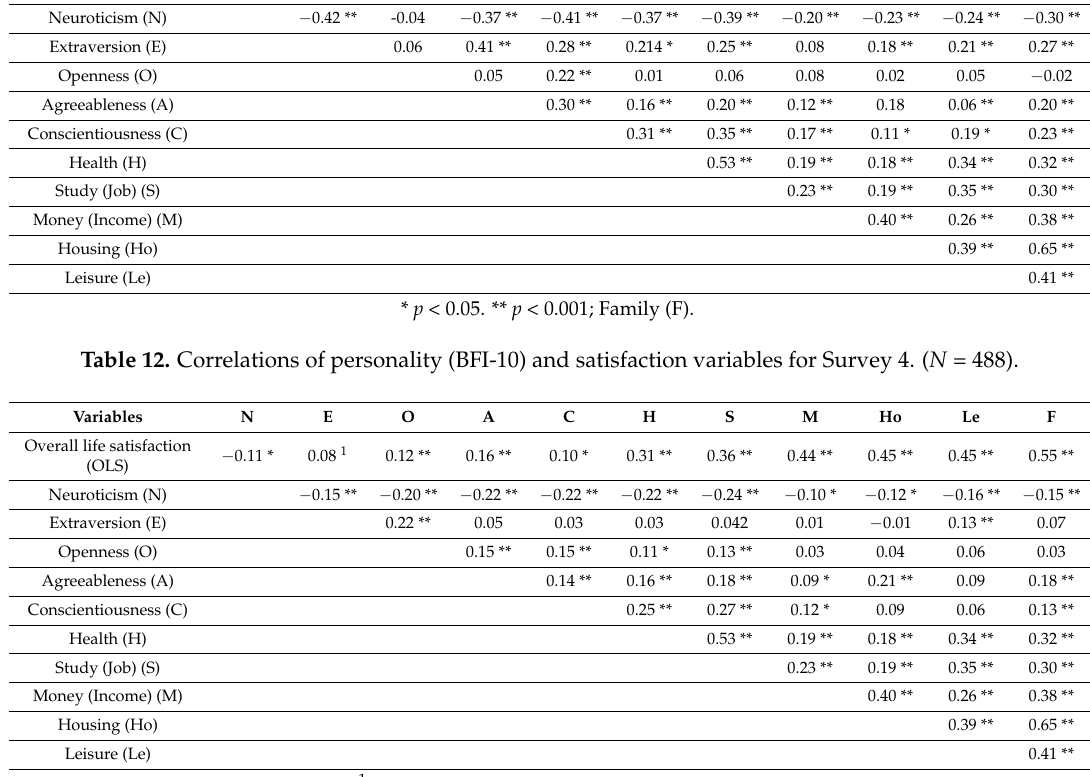
Table 11. Correlations of personality (NEO-FFI) and satisfaction variables for Survey 4. ( N = 488). Variables Overall life satisfaction (OLS)